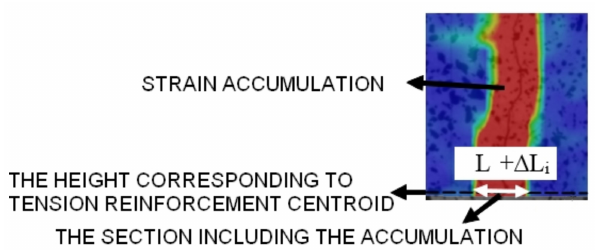
Figure 16. Crack width measurement scheme from DIC system.